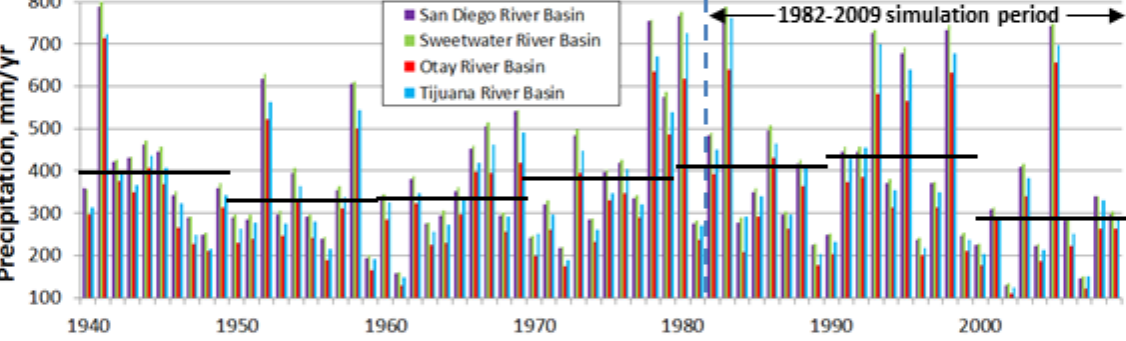
Fig. 2. Annual precipitation for 1940–2010 for the four major river basins in the San Diego/Tijuana study area with decadal mean precipitation indicated by the horizontal black lines. The gray shaded region indicates the groundwater model simulation